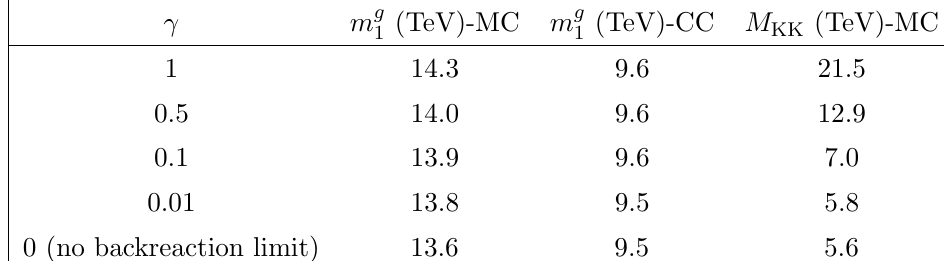
(cid:22)r = 25 and r = 40 M (cid:0) 1 . The last column Pl j j